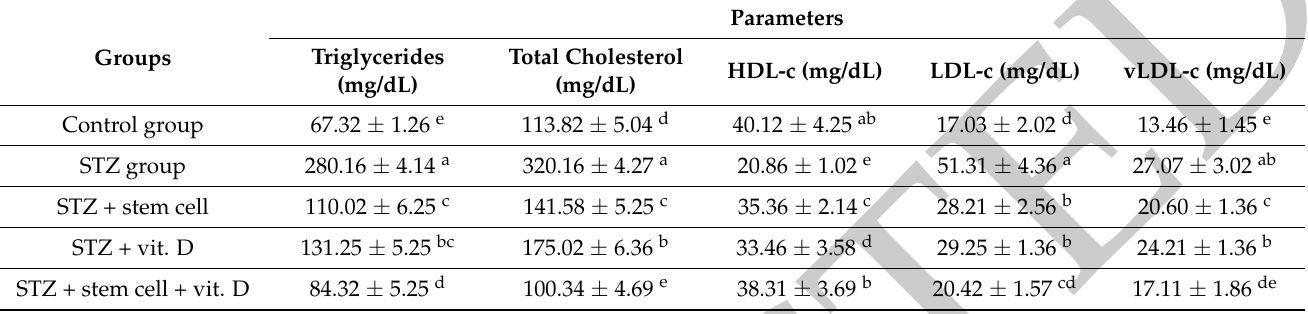
Table 2. Lipid profile of control and diabetic male rats treated with stem cells, vitamin D, and their combinations.